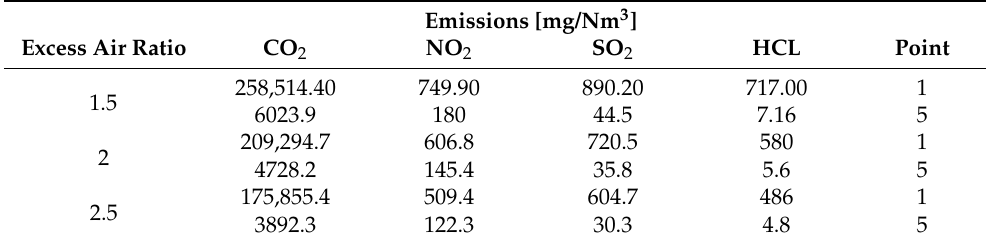
Table 15. Summary of results of the flue gas emission cleaning